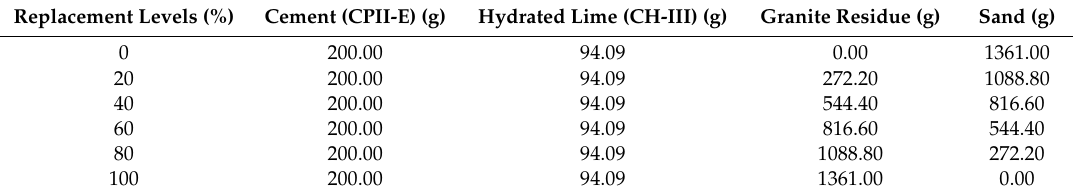
Table 1. Compositions of mortars